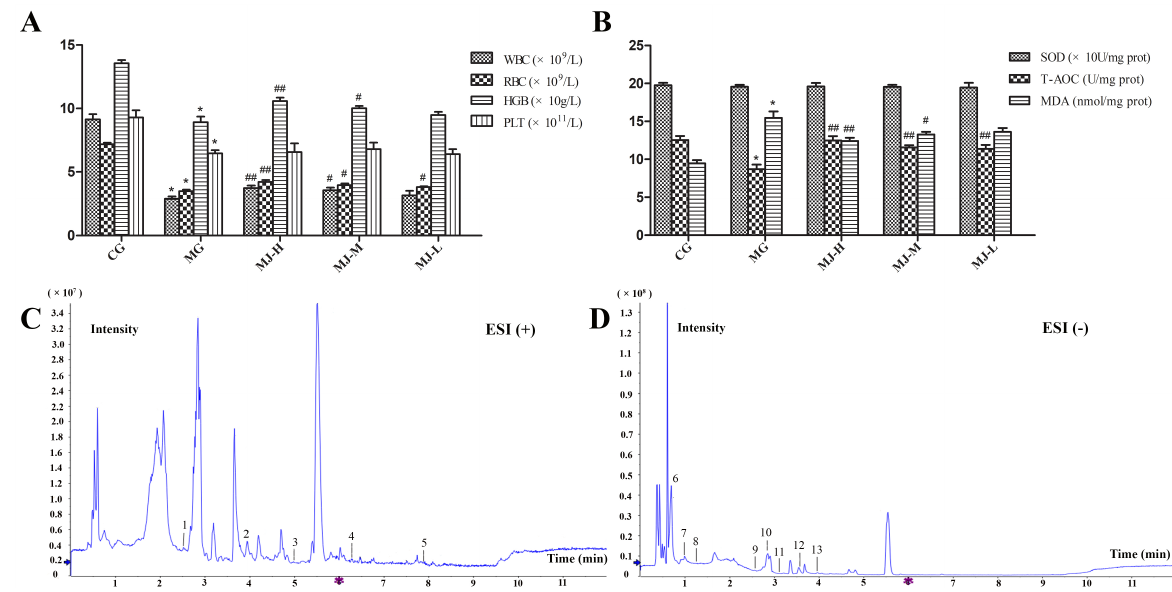
Figure 1. ( A ) Peripheral blood routine analysis. ( B ) Antioxidant activity analysis. ( C , D ) Rep- resentative base peak intensity chromatogram of plasma samples in MJ-H group derived from UHPLC–QTOF/MS, peak 1, Uracil; 2, Cytidine; 3, Picolinic acid; 4, L -Glutamate; 5, Glutathione disulfide; 6, Linoleic acid; 7, Formylanthranilic acid; 8, Bilirubin; 9, Uridine; 10, Protoporphyrin; 11, 5-Hydroxyindoleacetate; 12, Orotate; 13, L -Tryptophan. (* p < 0.01, compared with control